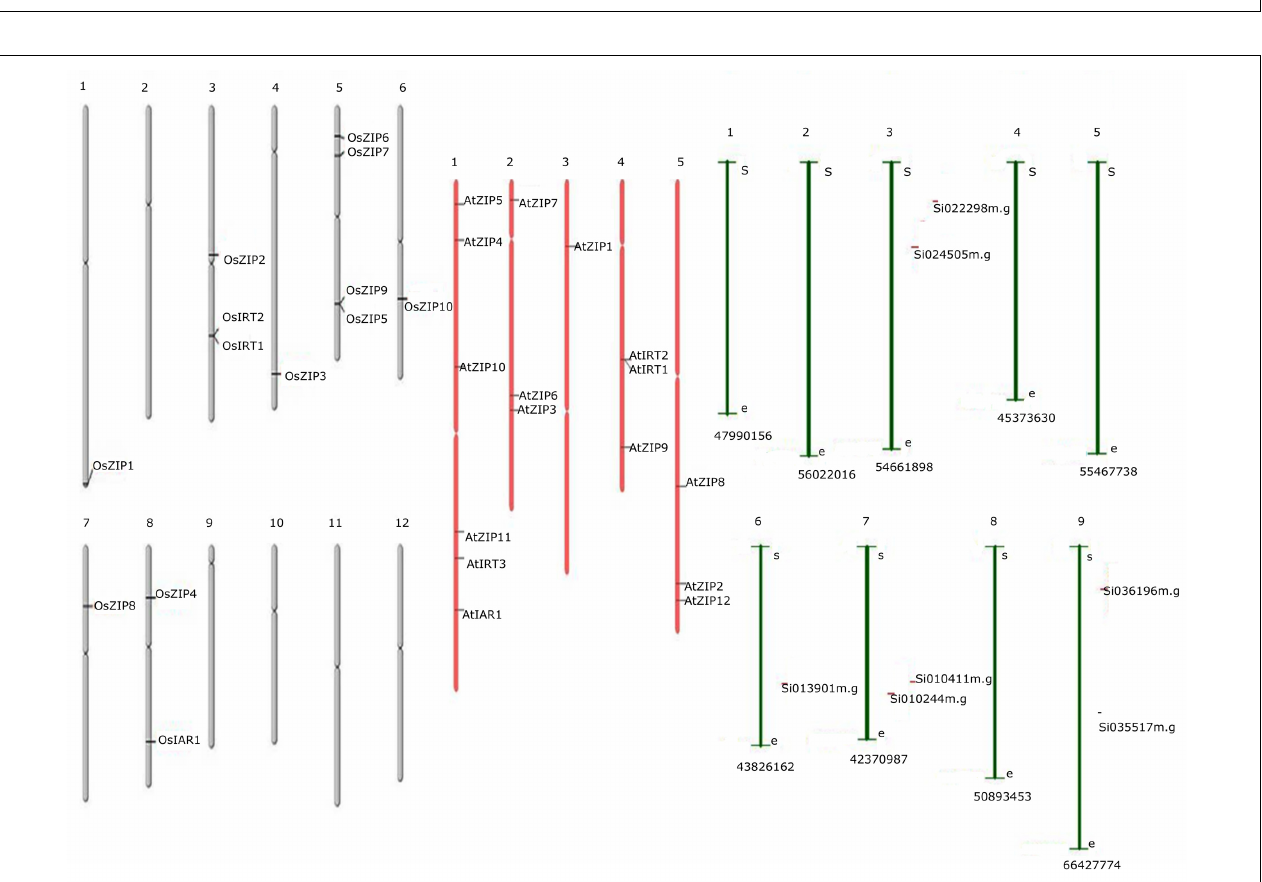
FIGURE 1 | Ortholgous genes for the ZIP family have been identified among three species viz. Arabidopsis, rice and foxtail millet. Seven orthologous clusters along with its Phylogenetic tree have been presented.